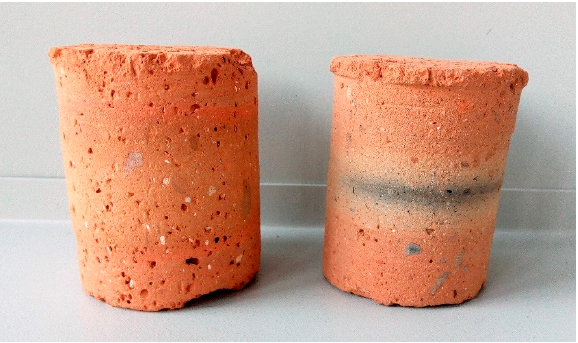
Figure 1. Cutouts of bricks: Vysoké Mýto (left) and Holešov-Žopy (right). Table 1. Selected properties of the tested bricks—specific surface area (m/g), total cumulative vol- ume (cc/g), total porosity (%) and bulk density (g/cm 3 ). The mean values from three replicates are used in the table.